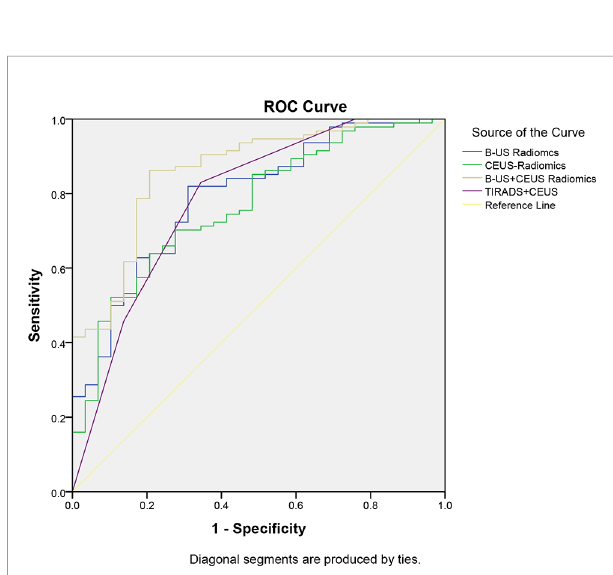
FIGURE 8 | Comparison of the AUCs of the four types of models.